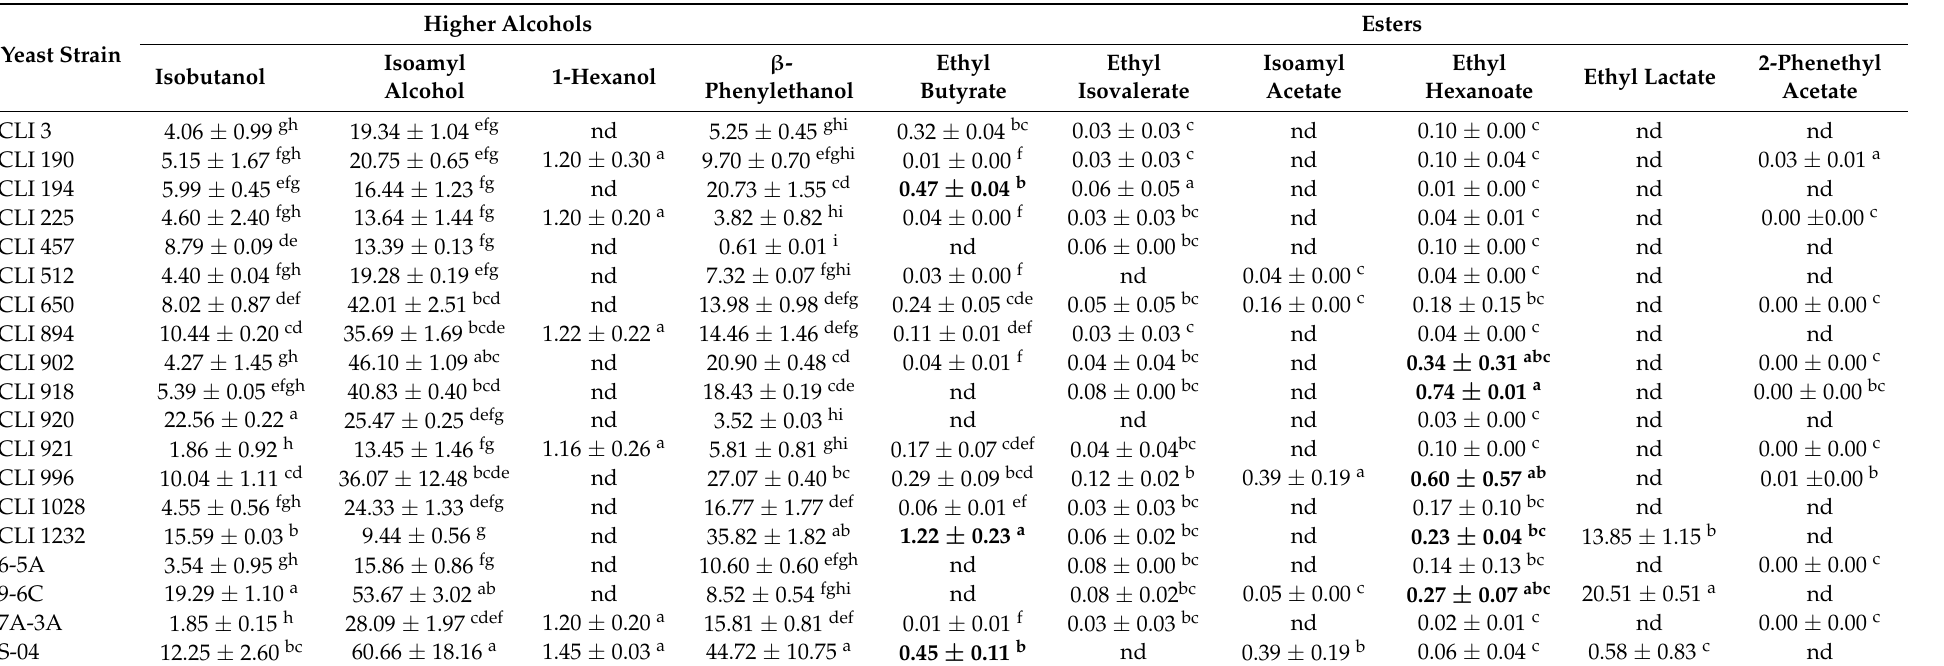
Table 3. The main volatile compounds (higher alcohols and esters) in the green beer produced by the different yeast strains (mg L − 1